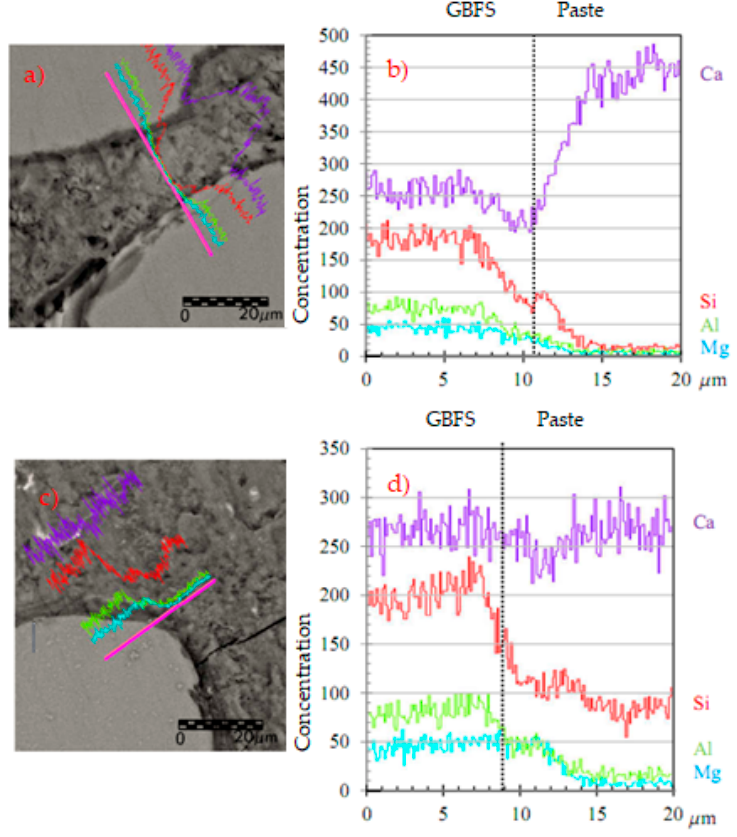
Figure 6. ( a ) SEM images of the interface at 1300 magnification to 28 days; ( b ) the analysis of the composition to 28 days; ( c ) SEM images to 120 days; ( d ) the analysis of the composition to 120 days.